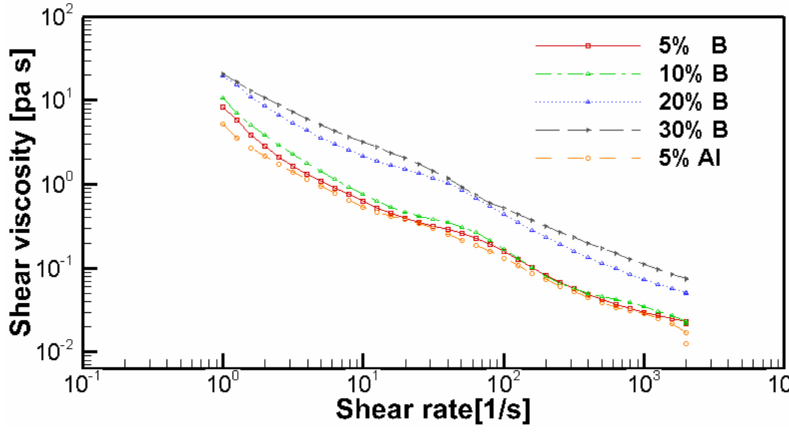
Figure 1. Shear viscosity vs. shear rate for test fuels.